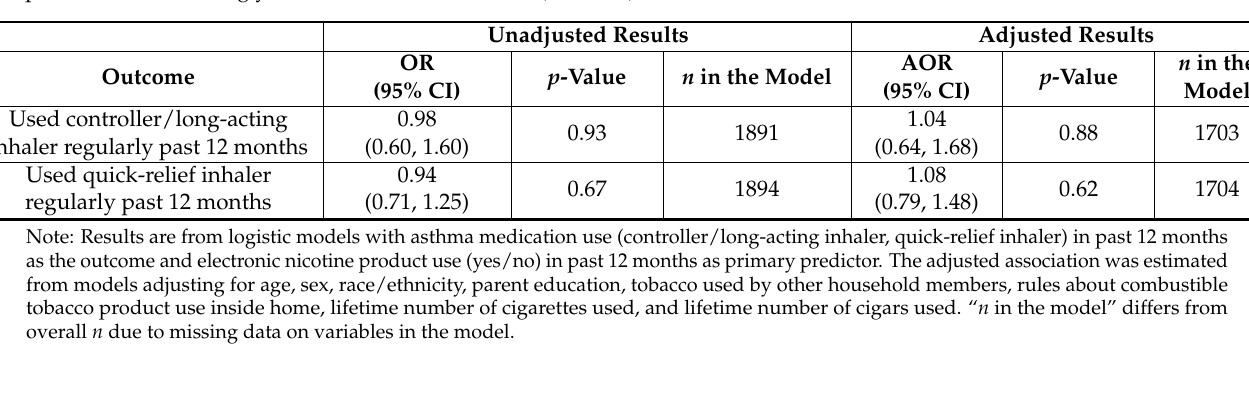
Table 3. Unadjusted and adjusted association between electronic nicotine product use and using asthma medications in past 12 months among youth who ever had asthma ( n =